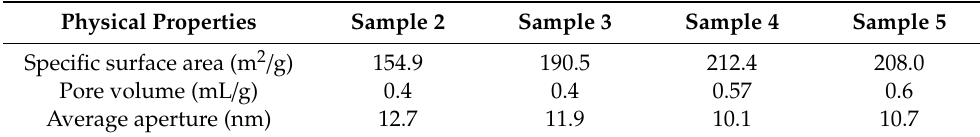
Table 3. Physical properties of the modified rare earth